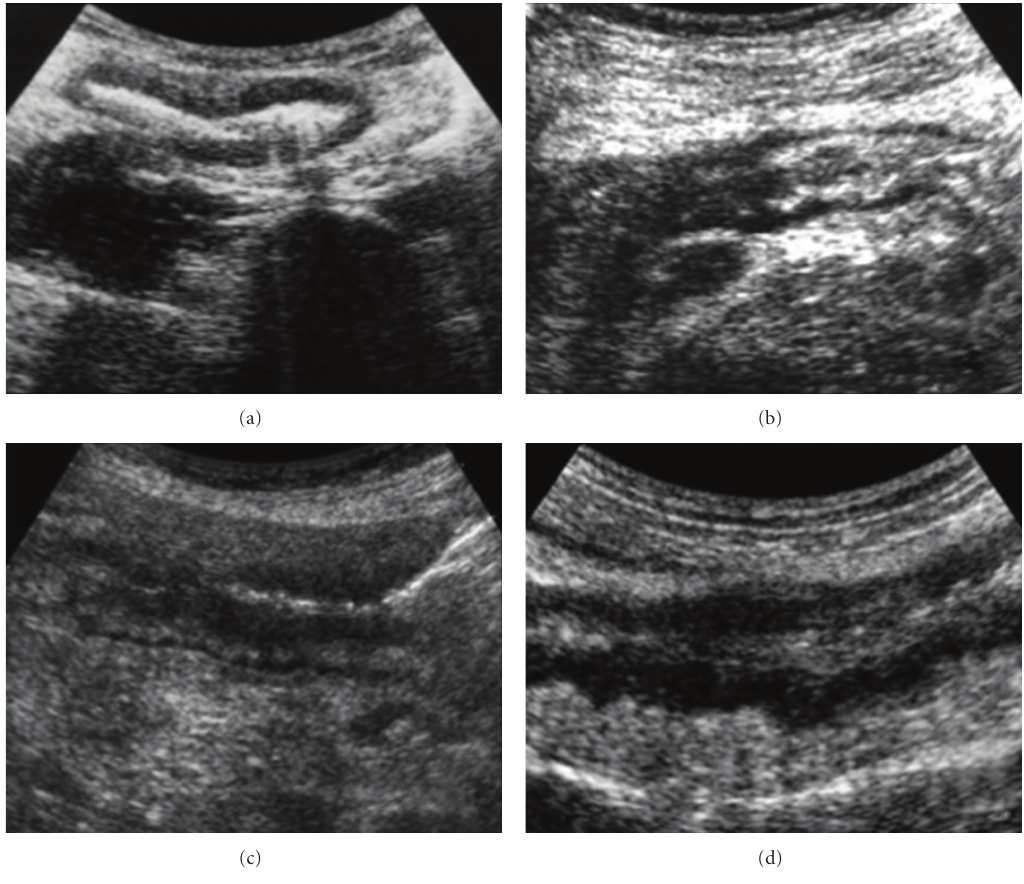
Figure 2: US. (a) Wall thickening without stratification and hyperecoic lumen. Regular outer margin of the loop. Mesenteric fat hypertrophy. (b) Coexistence of two patterns. Stenotic and thickened loop with preserved stratification and an adjcent segment with loss of stratification. (c) Stenotic intestinal tract characterized by marked dilatation of the bowel lumen, with thickened bowel wall. (d) Wall thickening with loss of normal stratification. Discontinuous outer margin with hypoecoic indented irregularities due to extramural